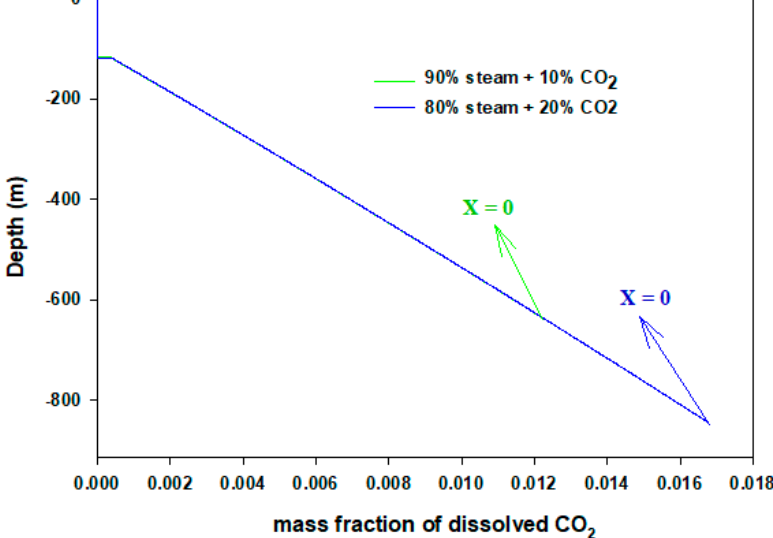
Figure 4. Dissolved CO 2 concentrations in condensates.